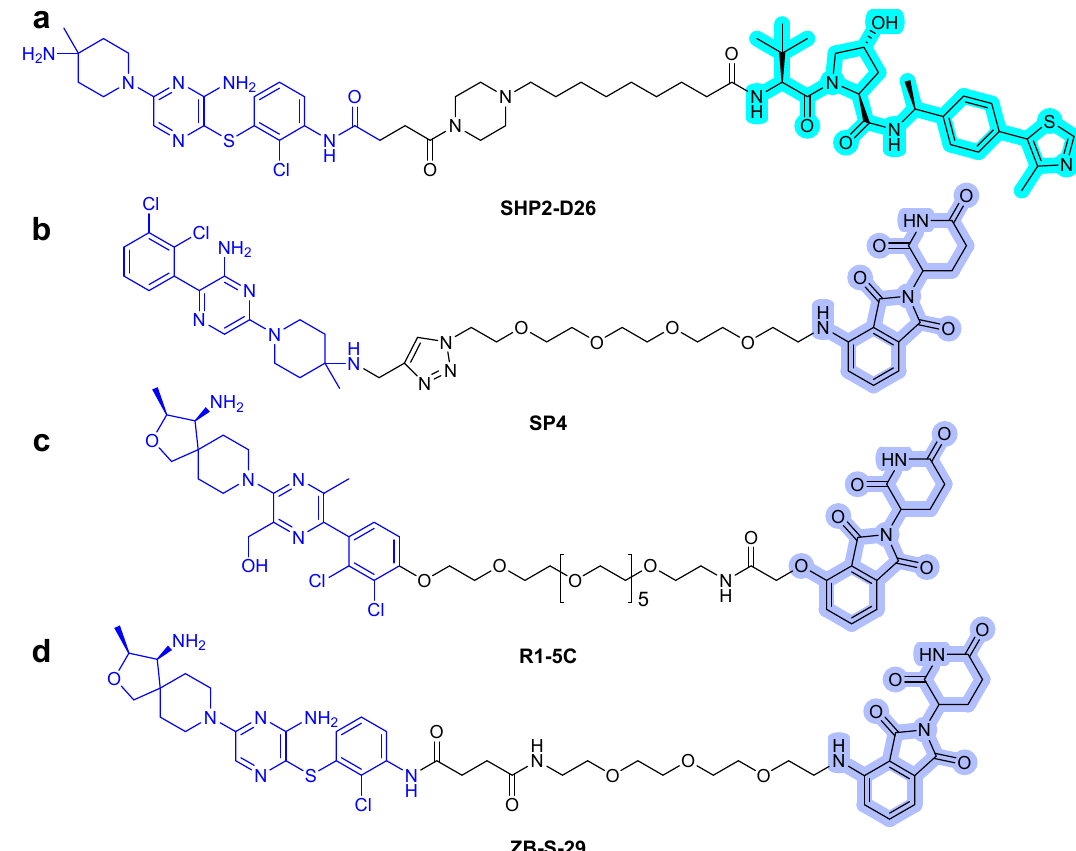
Figure 8. SHP2 degraders. ( a ) SHP099-derived SHP2 binder-VHL PROTAC. ( b ) SHP099-CRBN PROTAC. ( c ) RMC-4550- CRBN PROTAC. ( d ) TNO155-CRBN PROTAC. The colors show the part of each compound that is a structurally important binding motif. The ligands of the POI are depicted in blue color. VHL and CRBN ligands are highlighted in cyan and purple colors, respectively.